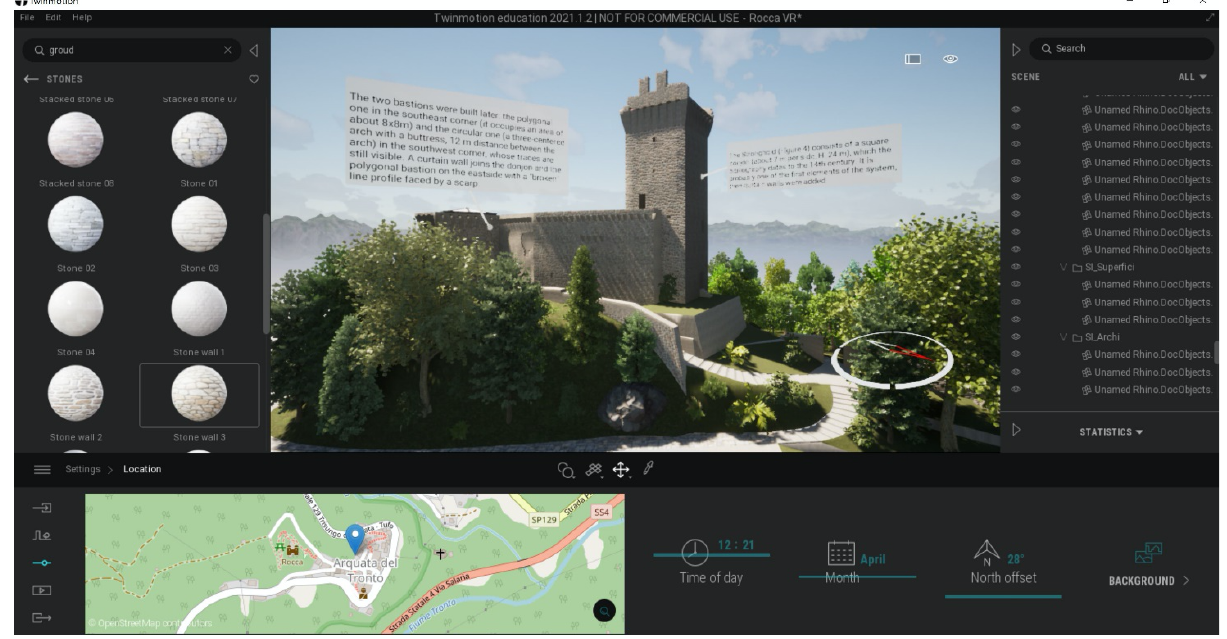
Figure 11. The VR project developed for the research case